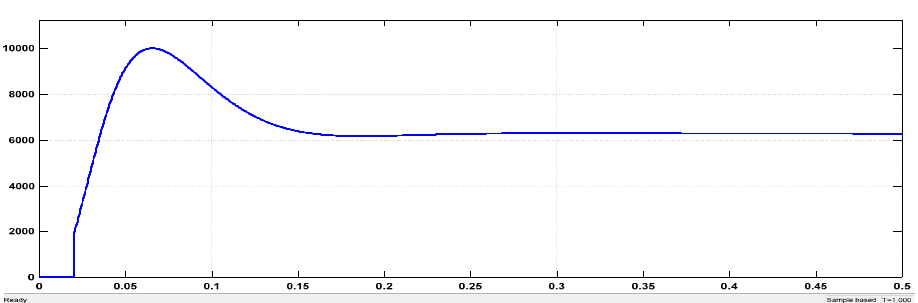
Figure 12. Active power output of the wind generator.